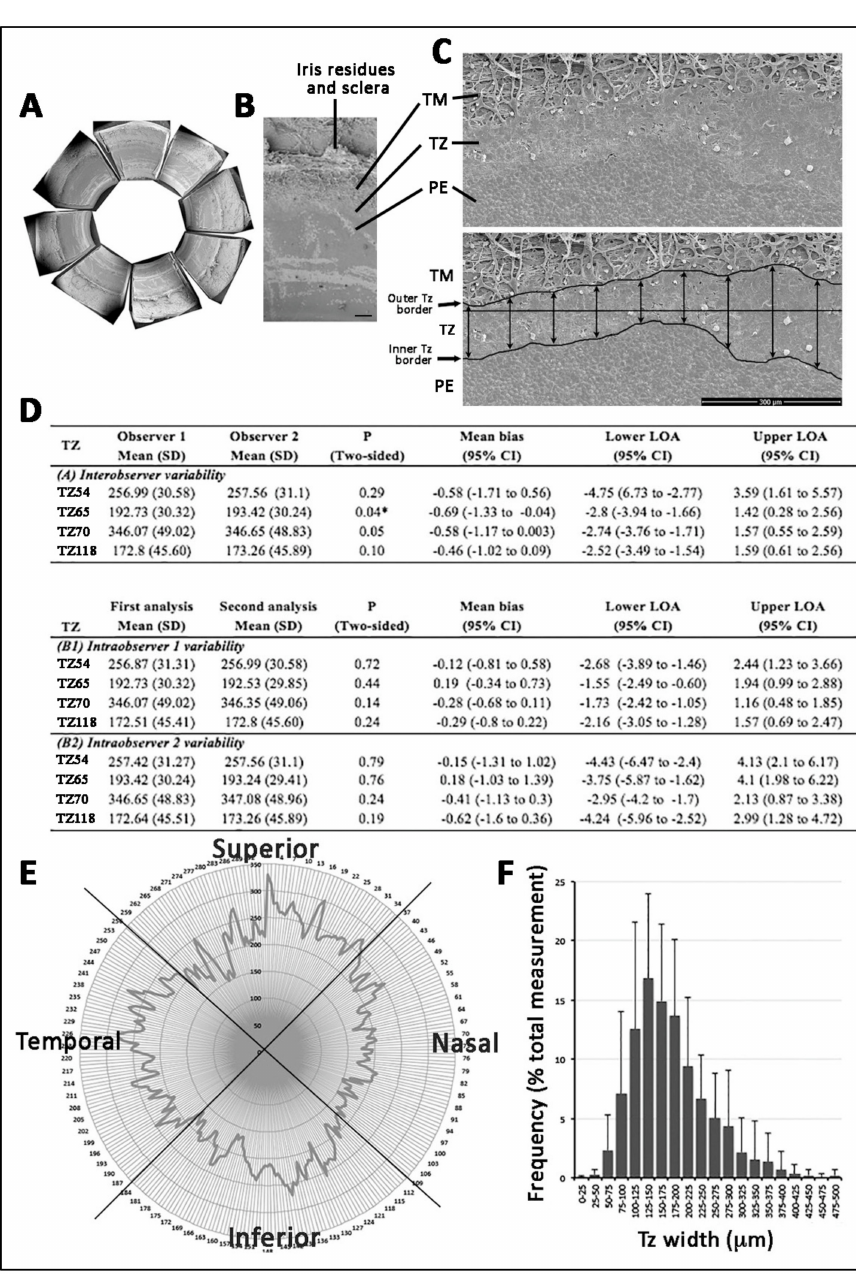
Figure 1. Human transition zone (TZ) morphology under scanning electron microscopy and TZ width profile. ( A ) Corneal periphery cut into equal pieces. ( B ) A magnified view showing regions of trabecular meshwork (TM), TZ and peripheral endothelium (PE). ( C ) Flat-mount view at 300 × magnification and TZ outline with posterior border at insertions of uveal bands into TM and anterior border of polygonal-shaped endothelial cells. At every 100 µ m interval, a vertical line was made between the inner and outer borders for TZ width measurement. ( D ) Inter- and intra-observer agreement of TZ width measurement. LOA: level of agreement. ( E ) 360 ◦ TZ width profile with respect to eye orientation. Nasal quadrant had the narrowest TZ. ( F ) A frequency plot of TZ width distribution. A dominant TZ width at 125 to 150 µ m (15% coverage of overall TZ widths). Scale bar: 300 µ m (B and